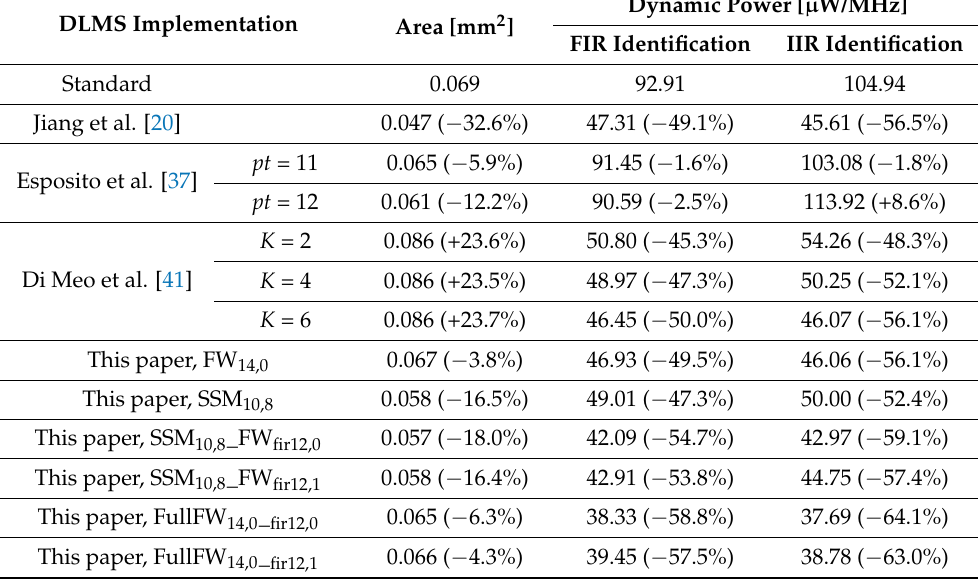
Table 3. Electrical